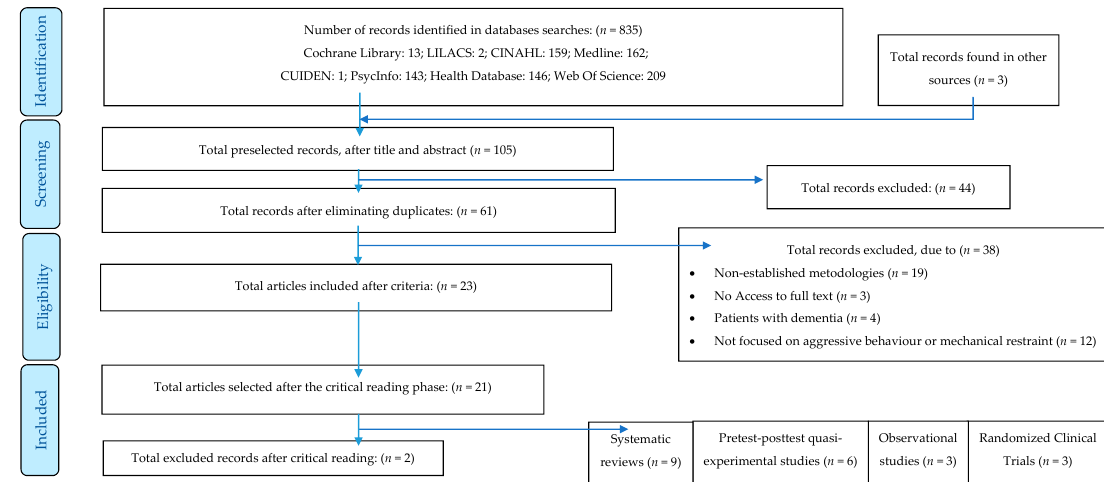
Figure 1. Preferred Reporting Items for Systematic Reviews and Meta ‐ Analyses (PRISMA) flow chart for the process of selection of studies in systematic reviews (adapted from Moher et al. 2009 [14]).